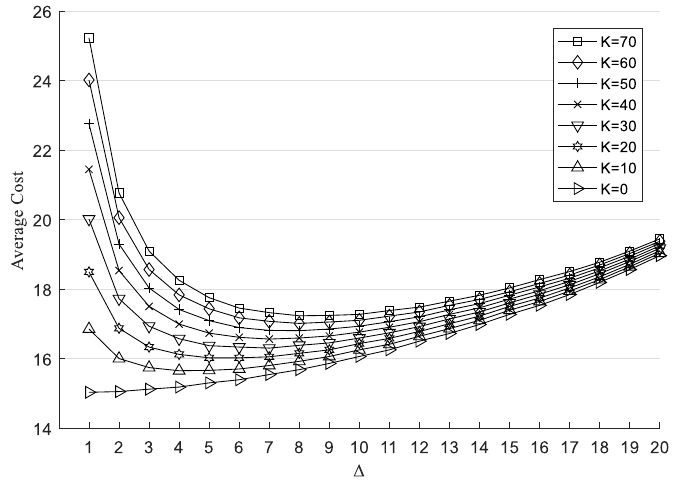
Figure 3. The average cost vs. 𝛥 = (𝑆 − 𝑠) for each value of the fixed cost for